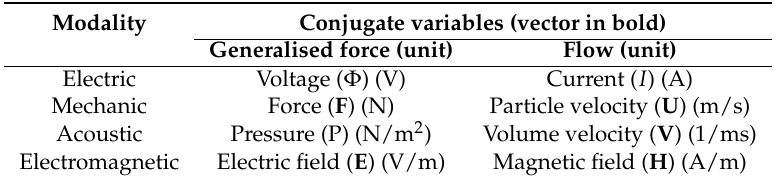
Table 1. Examples of modalities and their conjugate variables. Upper case symbols are used for the frequency domain variables except in the electromagnetic (EM) case, as its traditional notation uses capital letters for the time-domain analysis (i.e., E ( t ) = −∇ φ ( t ) , where φ ( t ) is the electric scaler potential and the voltage in the time domain. Modality Conjugate variables (vector in bold) Generalised force (unit) Flow (unit) Electric Voltage ( Φ ) (V) Current ( I ) (A) Mechanic Force ( F ) (N) Particle velocity ( U )